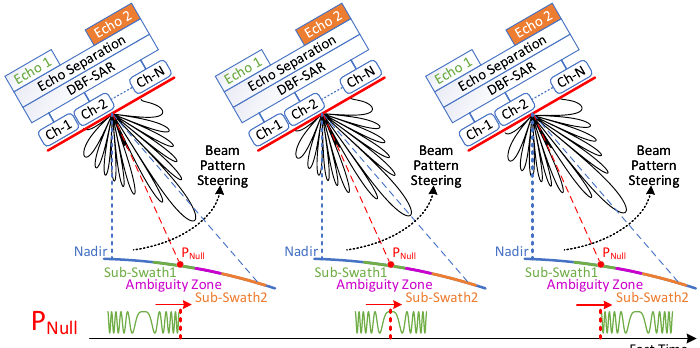
Figure 9. The principle diagram of the proposed